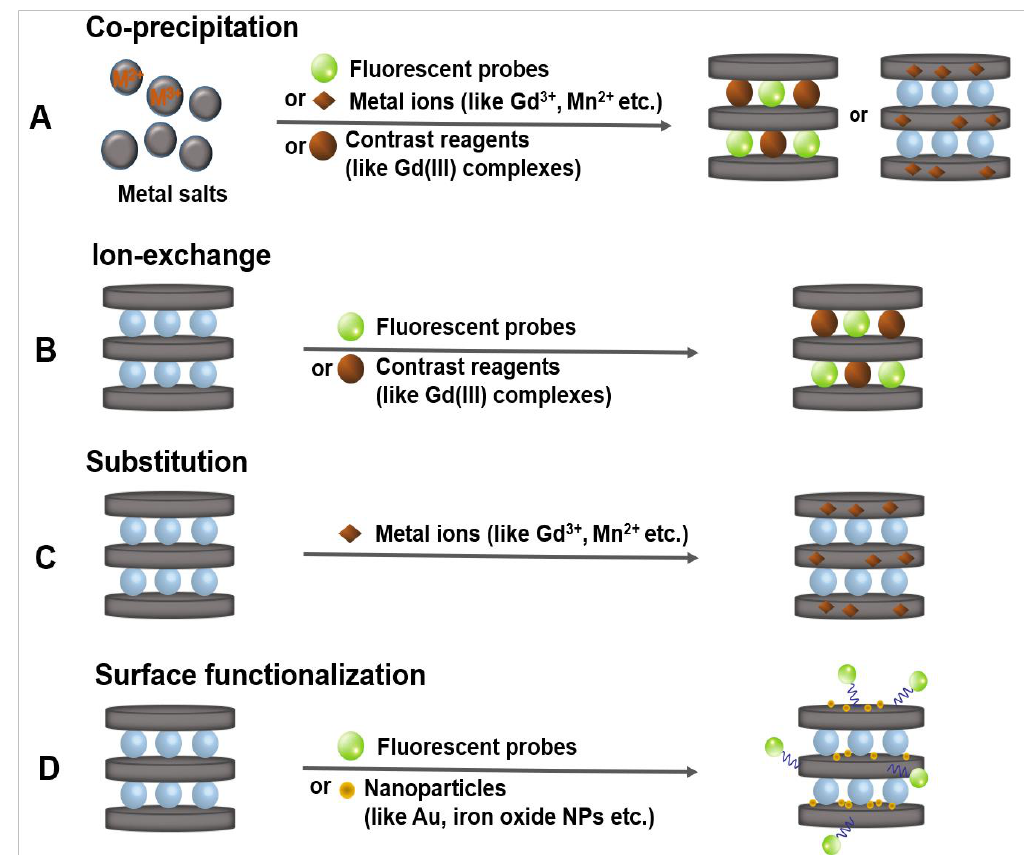
Figure 2. Synthesis strategies of functional LDH nanohybrids for bio-imaging, ( A ) coprecipitation, ( B ) ion exchange, ( C ) substitution, and ( D ) surface functionalization.